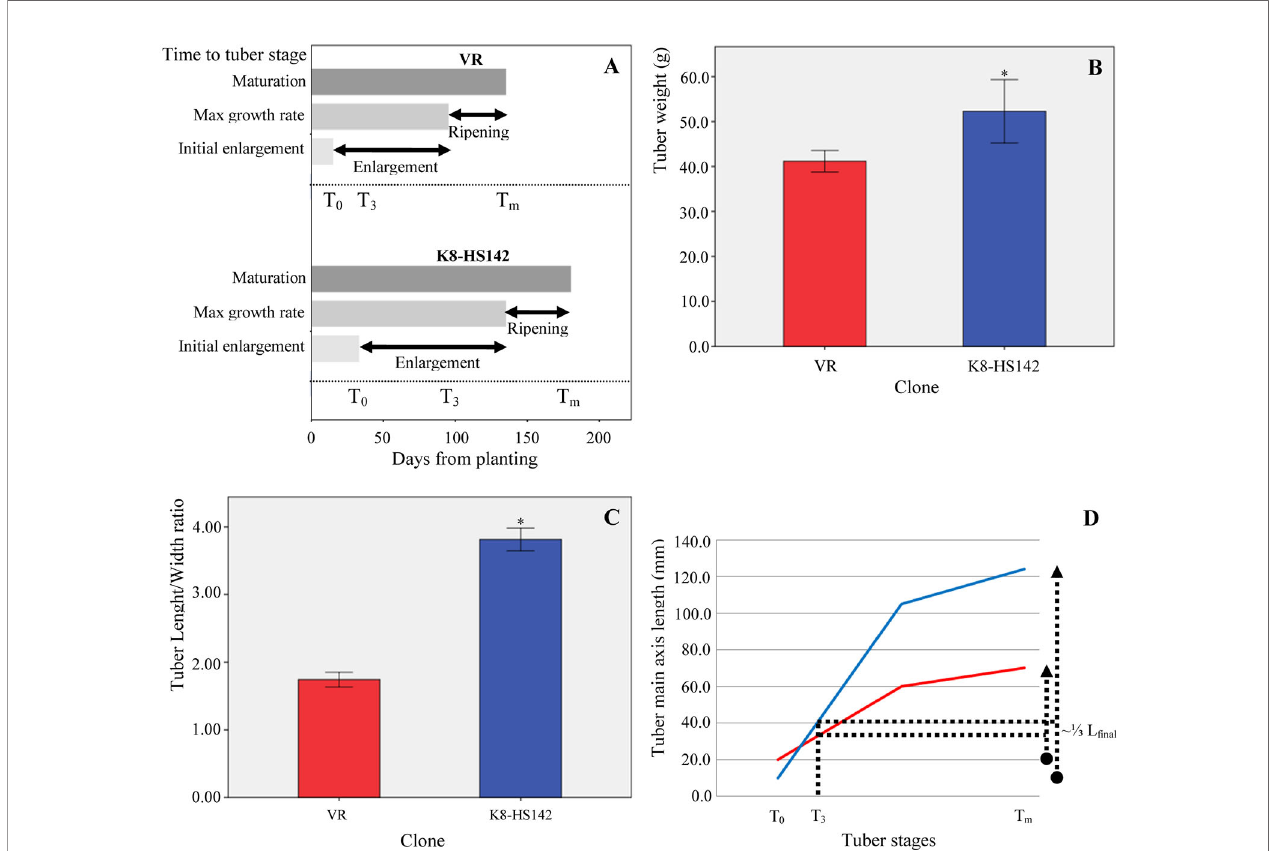
per clone. (B) Tuber weight. Data are from tubers collected from four different plants per clone. (C) Tuber shape . Ratio between length and width in tubers of “ VR ” and “ K8-HS142 ” clones, collected from four different plants. According to Pas'ko (1973) tubers from “ VR ” and “ K8-HS142 ” were classi fi ed as short pear-shaped